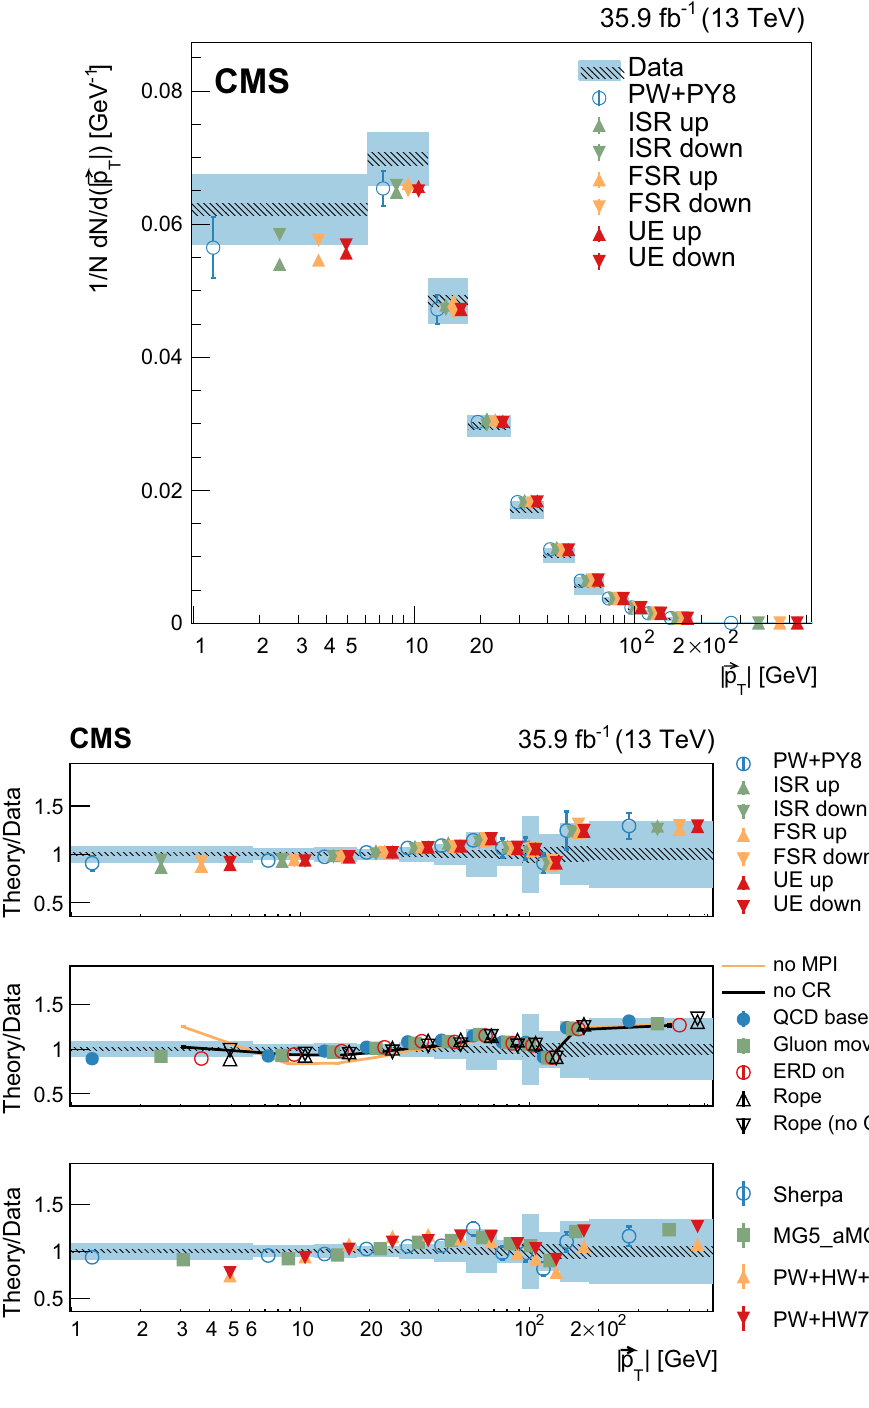
Fig. 7 Normalized differential cross section as function of | (cid:7) p T | , compared to the predictions of different models. The conventions of Fig. 4 are